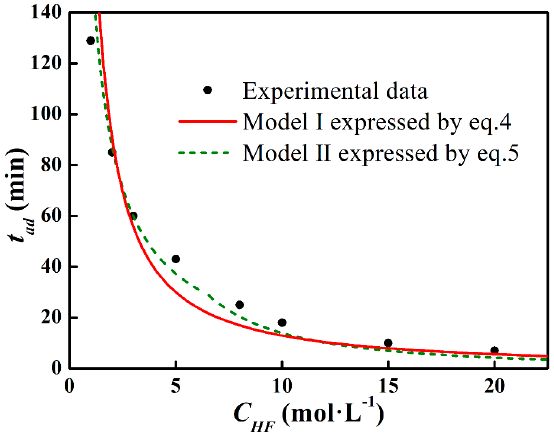
Figure 6. Arrhenius fitting of ln r in ln C HF domain at ( a ) whole range and ( b ) department ranges.